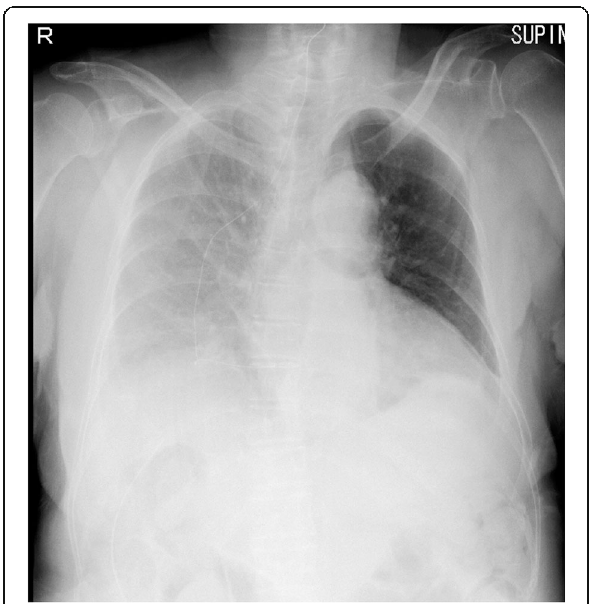
Fig. 1 Chest X-ray findings on POD 1. We confirmed a right pleural effusion in the chest X-ray image. The CTR showed increased to